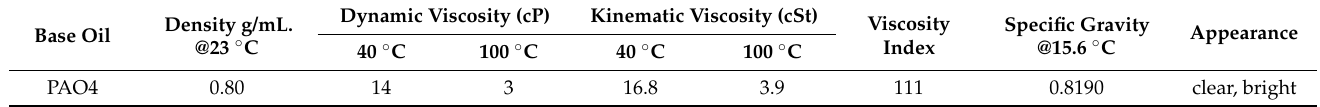
Table 1. Rheological properties of PAO base oil [10].